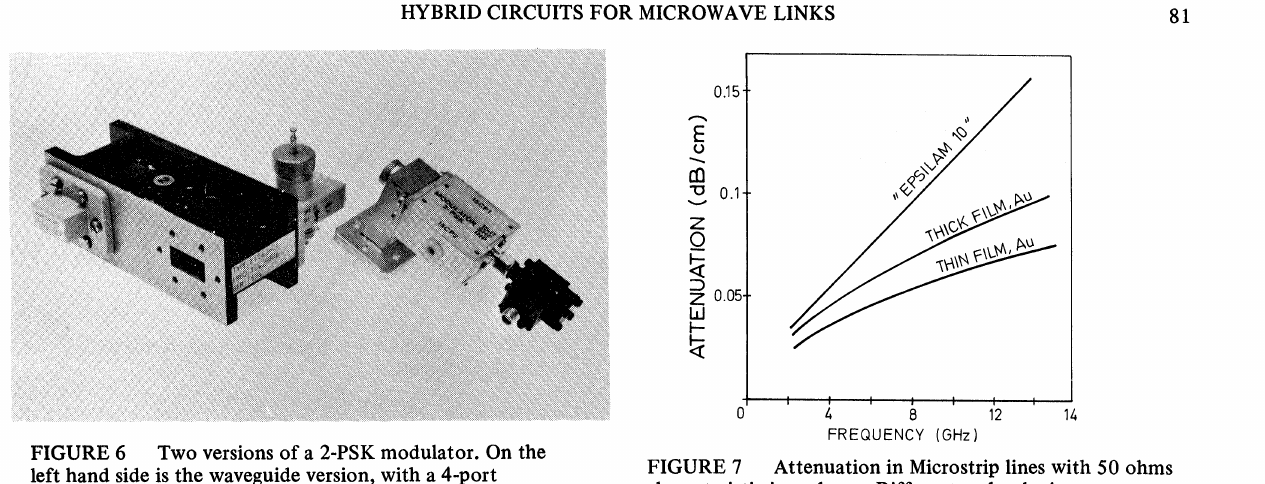
FIGURE 6 Two versions of a 2-PSK modulator. On the left hand side is the waveguide version, with a 4-port circulator. On the right hand side is the microstrip version, with a separate coaxial isolator.